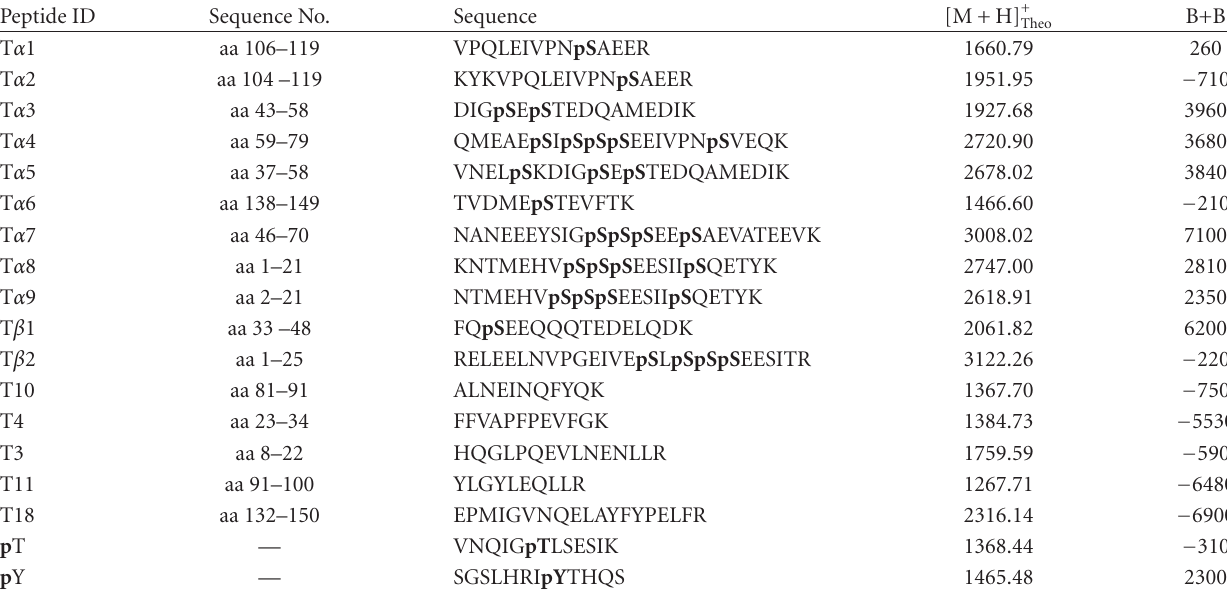
Table 1: The peptides investigated in this study ∗